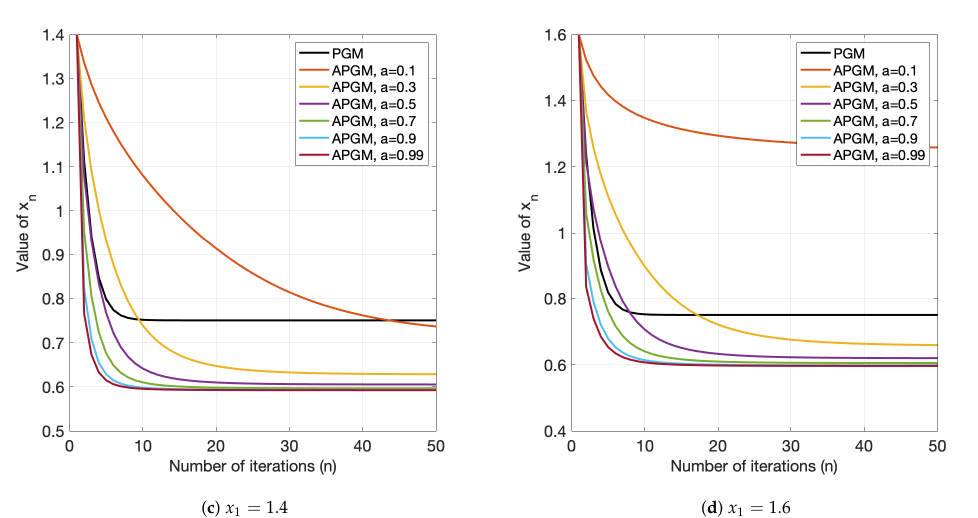
Figure 1. The behavior of the iterate x n for different values of the initial point x 1 when performed by PGM and APGM with various values for a .